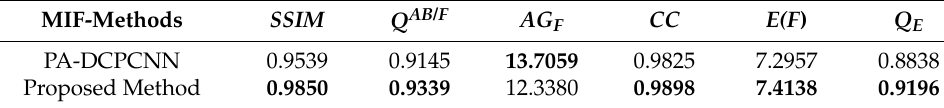
Figure 11. Multi-focus image of a book from various perspectives. Original Image: ( a ), Multi-focus Input Images: ( b , c ), and Proposed Fusion: ( d ). Table 5. The results and comparisons for book image ([20]).